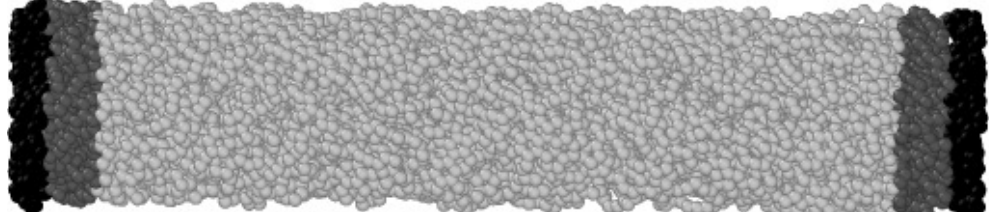
Figure 1. Snapshot of the system configuration used to calculate thermal conductivity. Colors represent different regions: fixed atoms (black), thermostat region (dark gray) and heat-flow region (light gray).